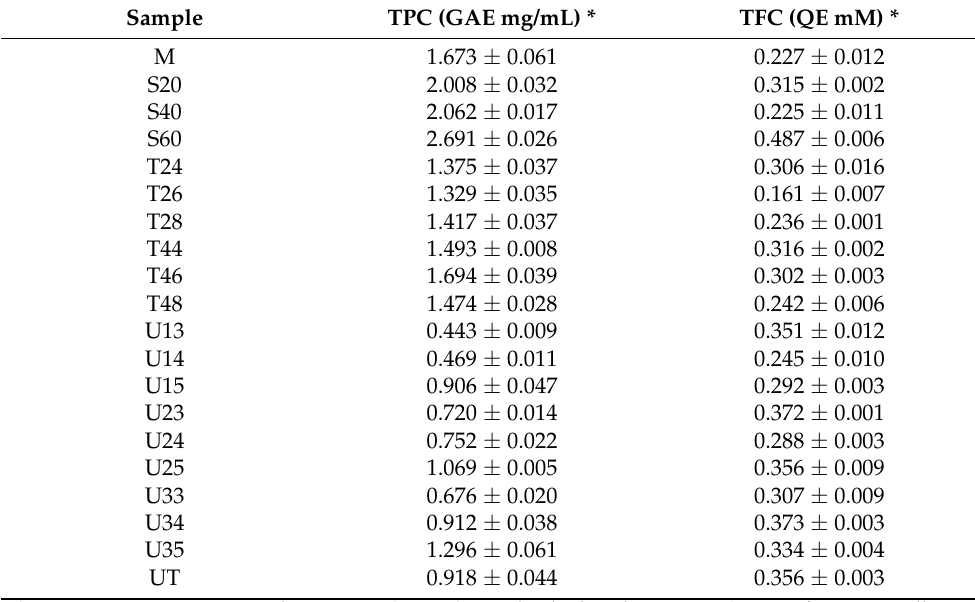
Table 2. Total polyphenolic content and total flavonoid content of the green coffee beans extracts.